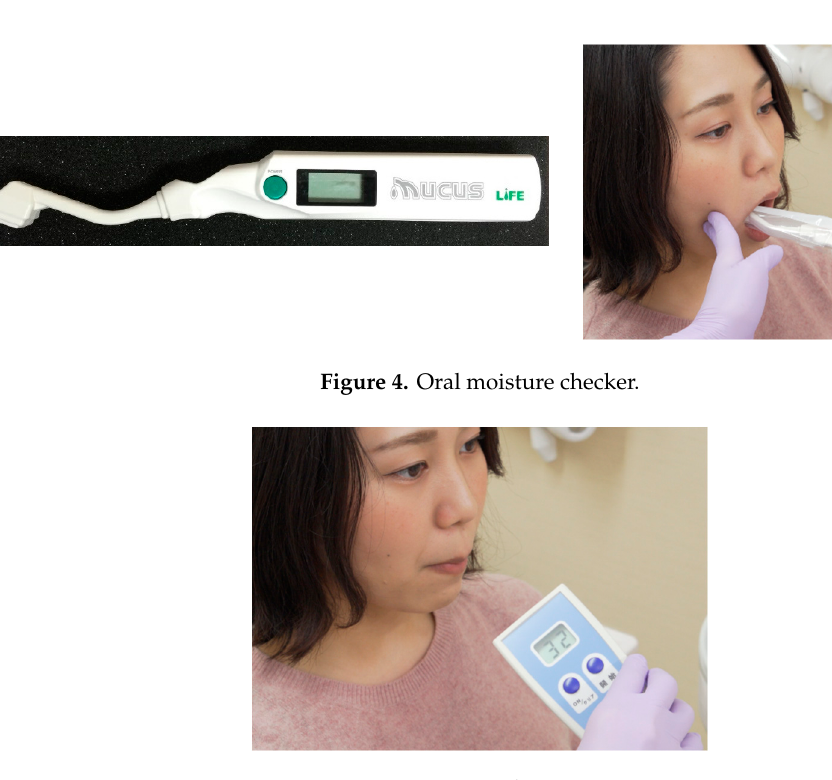
Figure 5. Digital counter Figure 6. Digital tongue pressure meter.